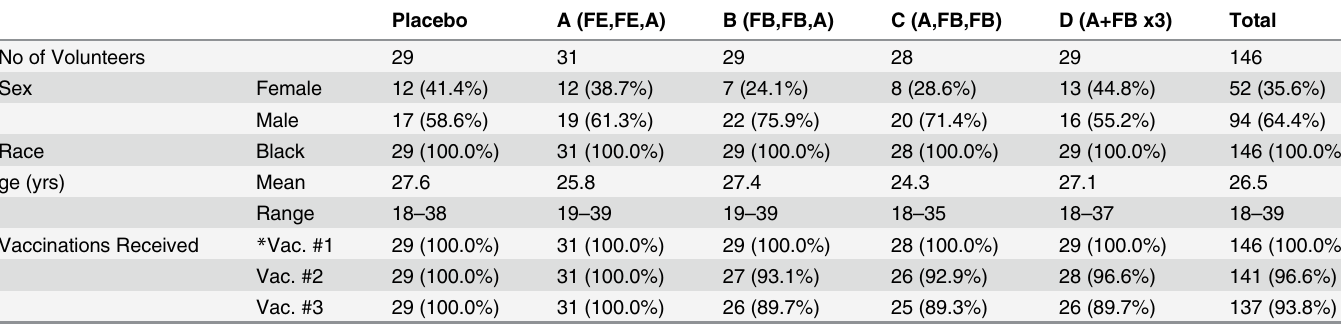
Table 1. Baseline characteristics by treatment